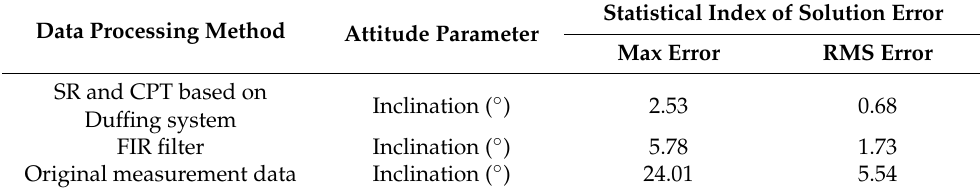
Table 3. Error statistics of the attitude solution.